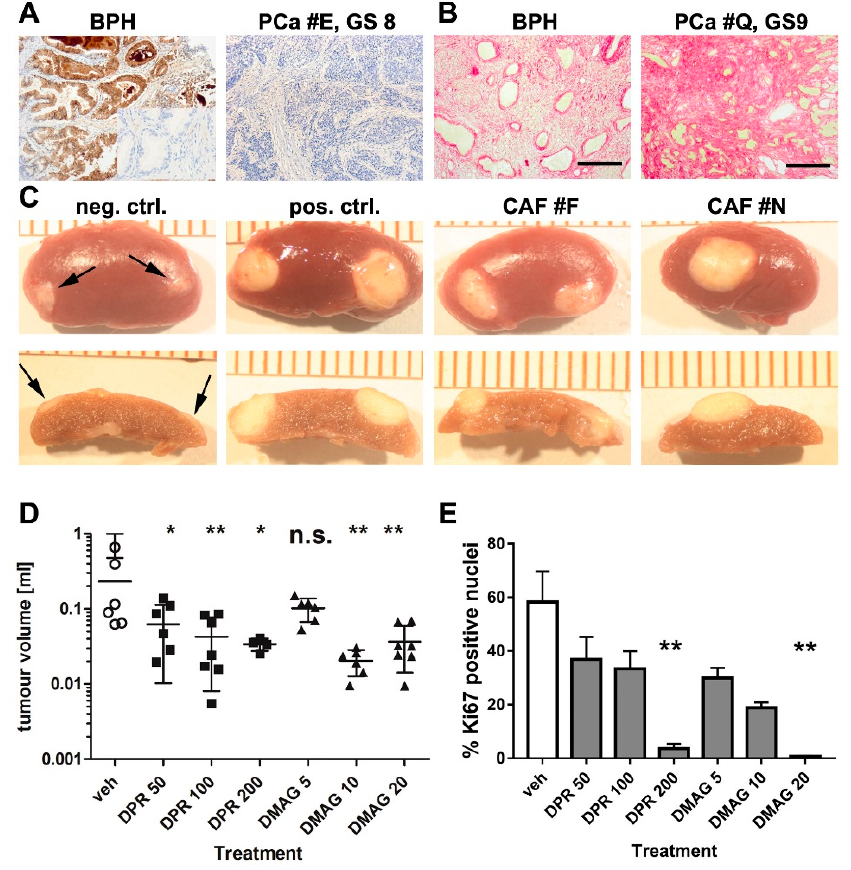
Figure 1. Characterisation of cancer-associated fibroblasts (CAF) and inhibition of tumour size and proliferation after treatment with HSP90 inhibitors. ( A ) Immunohistochemistry for Microseminoprotein (MSMB) showed positive staining in non-malignant benign prostatic hyperplasia BPH tissue (left panel; inset: antibody control) but was mostly absent in PCa (right panel) and was used to confirm tumour presence in tissue from which CAF were derived. Microscopy with 10× objective lense; PCa panel has identical scale as images in (B) (scale bar 200 μ M). BPH images also with 10× objective lense but illustration at half the size as the other images in (A,B); ( B ) Collagen was stained by picrosirius red in BPH (non ‐ malignant) and prostate cancer with a Gleason score of 9. Collagen was more abundant in prostate cancer samples. Microscopy with 10× objective; scale bar 200 μ M; ( C ) Recombination of normal prostate fibroblasts (neg. ctrl., negative control) with BPH1 cells and kidney capsule grafting produced little growth (arrows). Recombination of previously validated CAF (pos. ctrl., positive control) and CAF isolates F and N with BPH1 cells led to tumour growth, demonstrating pro ‐ tumourigenic activity of our primary CAF. Images in the upper row shows gross morphology, while the lower row shows cross sections of tumours used for size measurements; ( D ) CAF/BPH1 tumours were grown for 2 months followed by a 1 month treatment with vehicle control (veh), dipalmitoyl ‐ radicicol (DPR) at 50, 100 and 200 mg/kg or with 17 ‐ DMAG (DMAG) at 5, 10 and 20 mg/kg. Tumour size was reduced after treatment with dipalmitoyl ‐ radicicol at all doses, and with DMAG at 10 or 20 mg/kg. The vehicle control group was the same for both treatment groups since tests were performed simultaneous in parallel. Data are presented as mean + S.E.M. and asterisks denote the level of significance * for p < 0.05, ** for p < 0.01 and *** for p < 0.001. n.s. = not significant. Statistical test: one ‐ way ANOVA. Individual data are provided in Supplementary Table S2; ( E ) To examine effects upon cell proliferation within tumours, tissue sections of CAF/BPH1 tumours were